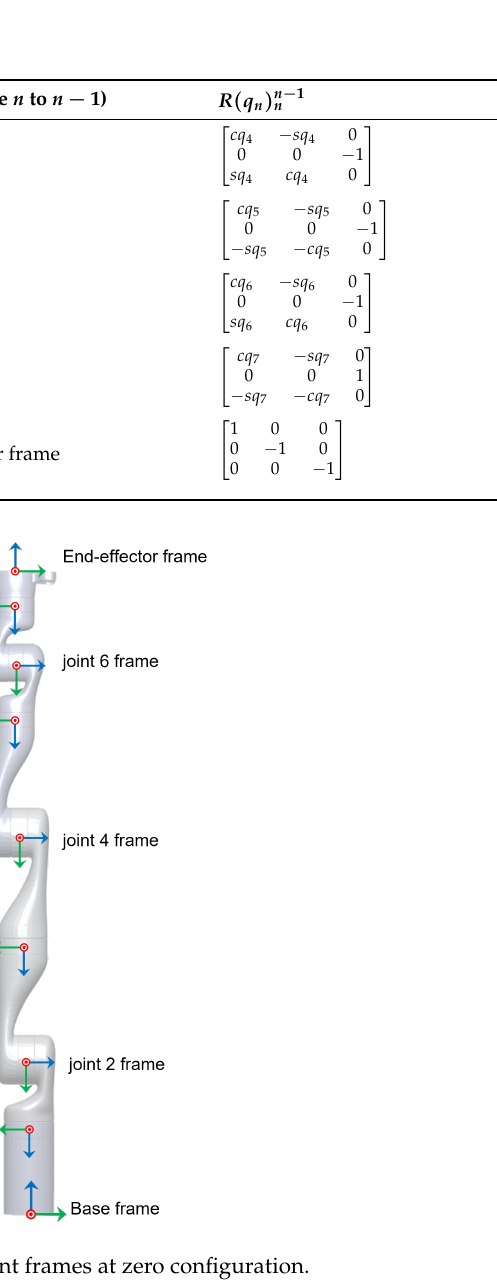
Figure 1. Kinova Gen3 joint frames at zero